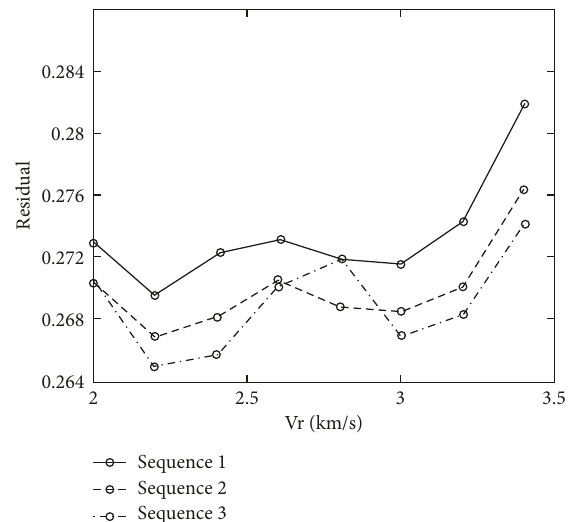
Figure 6: Rupture velocity sensitivity for rupture sequence 1, 2, and 3. The velocity is tested from 2.0 to 3.4km/s. The preferred model has a value of